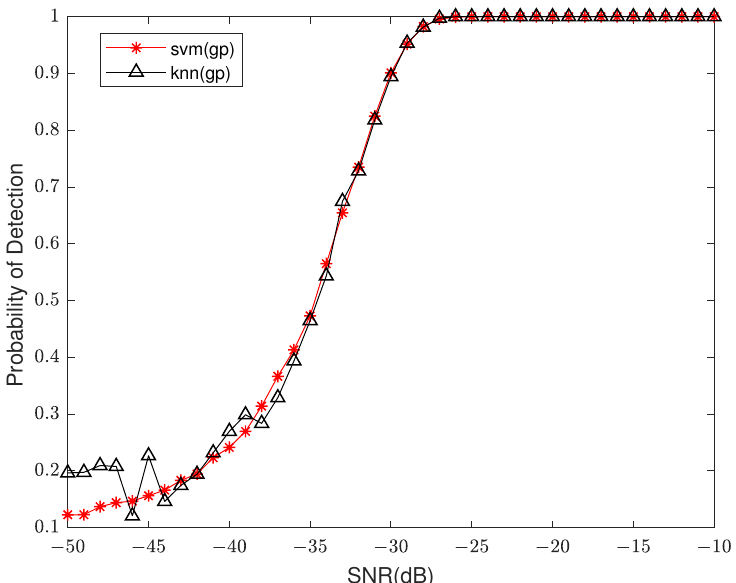
Figure 4. Performance comparison of GP-based SVM and KNN spectrum sensing